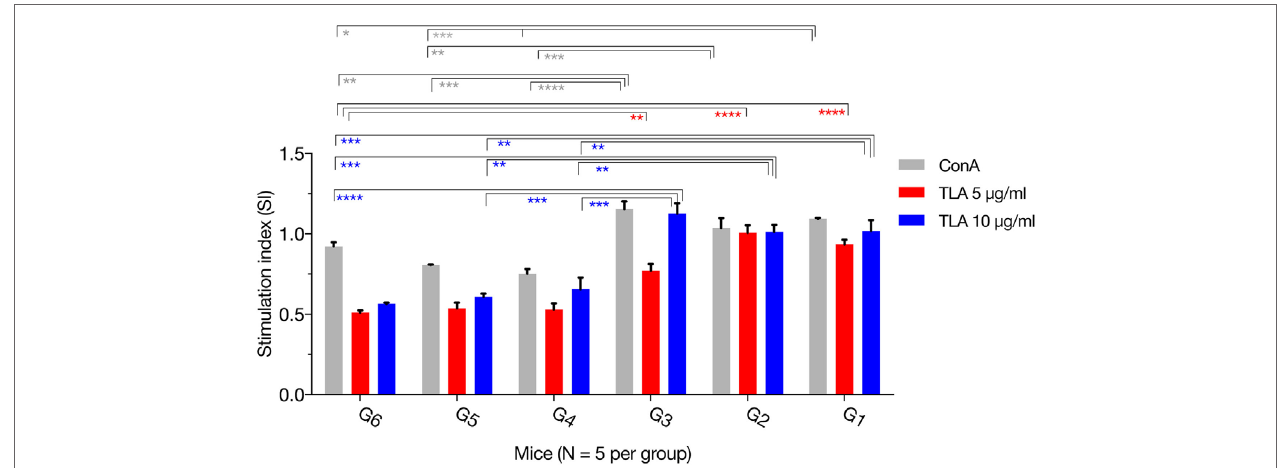
FigUre 3 | In vitro lymphocyte proliferation induced by immunization. Splenocyte proliferation was assessed in mice 2 weeks after the final booster immunization. Exposure of splenocytes to 10 or 5 µg/ml T. gondii lysate antigen (TLA) significantly increased T cell proliferation in splenocytes obtained from mice in G1, G2, and G3, compared with proliferation in the control using antigen alone suggesting the induction of antigen-specific T-cell immune response after DNA immunization. Experimental groups include G1: mice received pVAX1 plasmids containing five antigens (ROP16, ROP18, MIC6, CDPK3, and PF); G2: mice received pVAX1 plasmids containing four antigens (ROP16, ROP18, MIC6, and CDPK3); G3: mice received pVAX1-PF; G4: mice received an empty pVAX1; G5: mice received phosphate-buffered saline alone; G6: healthy control mice. Each sample was assayed at least in triplicate. Data represent the mean ± SD (error bars) from the five mice. * p < 0.05, ** p < 0.01, *** p < 0.001, and **** p < 0.0001, compared with the control